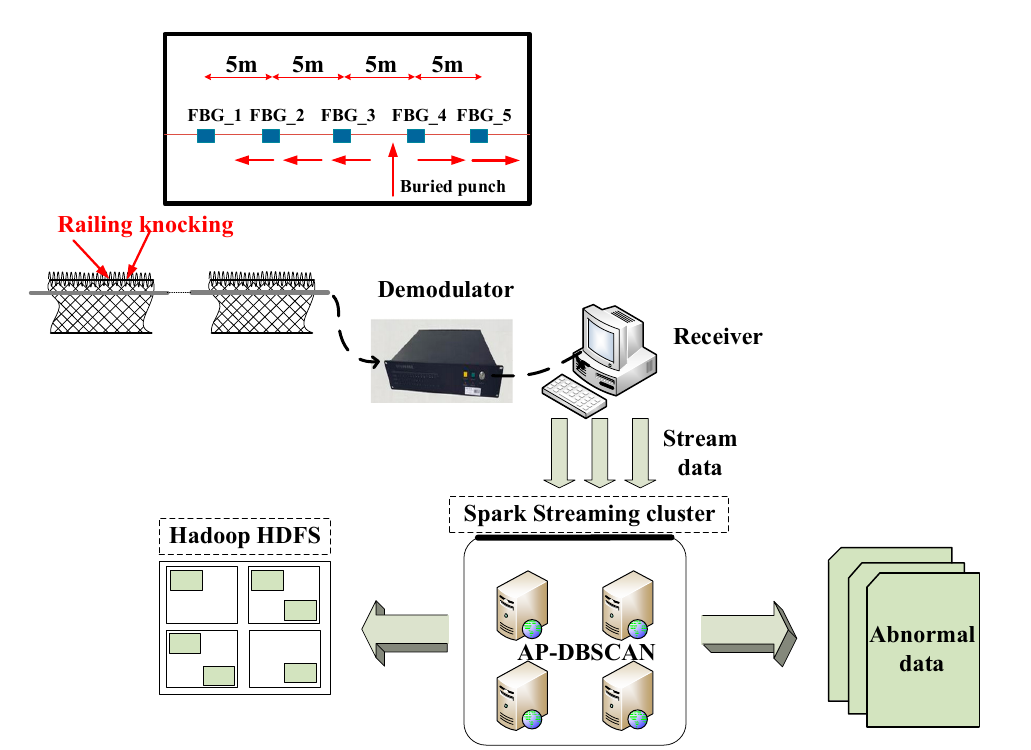
Figure 3. Architecture of the intrusion monitoring and identification system.